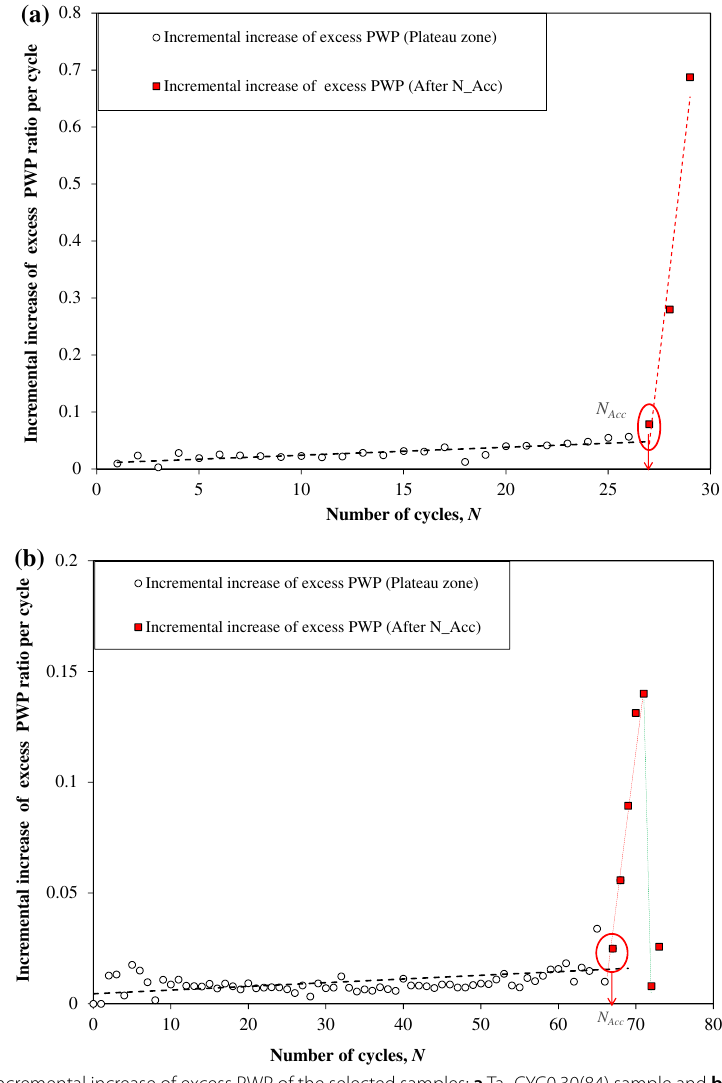
Fig. 9 Incremental increase of excess PWP of the selected samples: a Ta_CYC0.30(84) sample and b RaSa_ the cyclic axial strain, regardless of the number of cycles, CSR, density conditions, and material types. In addition, the interpretation shown can be separated into four stages of behaviors, corresponding to four zones in Fig. 10. Up to the cyclic axial strain of 0.2% (Zone 1), the excess pore water pressure ratio ( r u ) increases slightly and reaches approximately 0.20. In this stage, the samples are considered as “stable”. At the cyclic axial strain between 0.2 and 1.0% (Zone 2), the pore pressure ratios range from moderate to relatively high. In this stage, the samples are considered as “meta- stable”. Zone 3 (at the cyclic axial strain between 1.0 and 2.67%) includes all excess pore water pressure data at N Acc , involving the acceleration of the excess pore water pressure incremental increase as mentioned earlier. In this stage, the samples are considered as “unstable”. Finally, Zone 4 (at the cyclic axial strain larger than 2.34%)